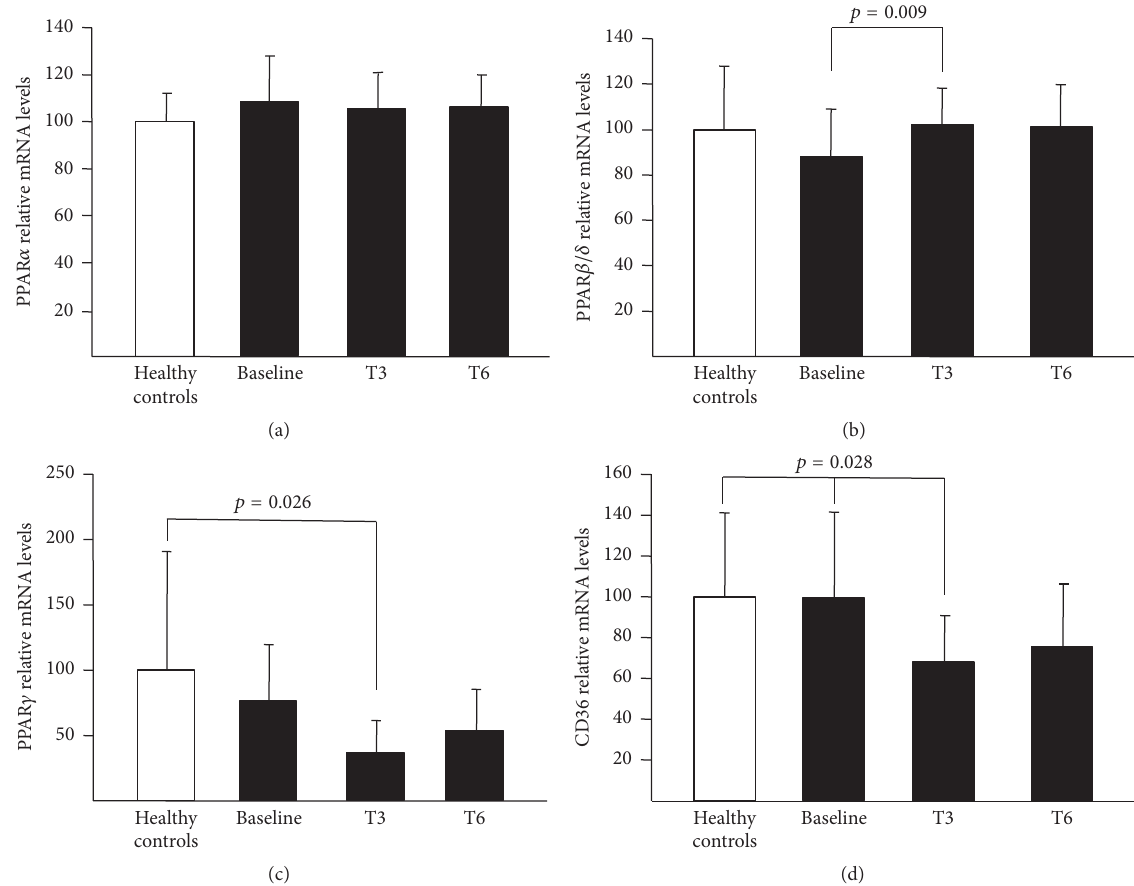
Figure 1: Expression of PPAR 𝛼 , PPAR 𝛽 / 𝛿 , PPAR 𝛾 , and CD36 in PBMC of healthy controls and patients. PBMC were isolated from healthy controls and patients at baseline and after 3 (T3) or 6 months (T6) of treatment with NTZ. mRNA levels of PPAR 𝛼 (a), PPAR 𝛽 / 𝛿 (b), PPAR 𝛾 (c), and CD36 (d) were measured by Q-PCR. The relative expression of eachgene was calculated as described above, normalized to cyclophilin mRNA, and expressed as means ± SD relative to healthy controls set at 100.